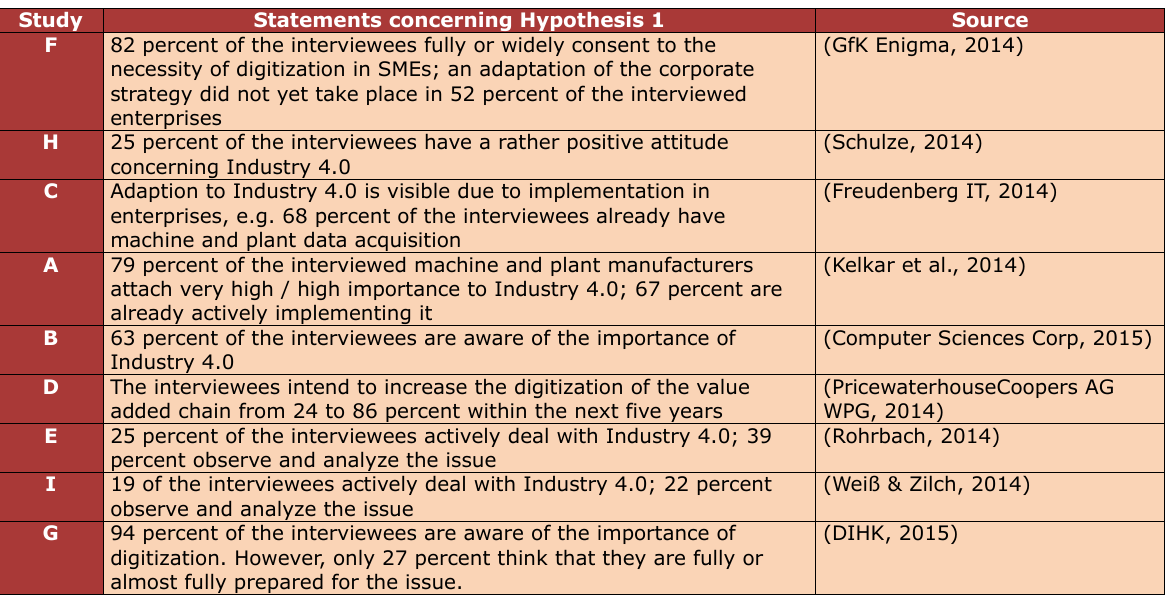
Table 2. Overview of the enterprise sizes examined in the different